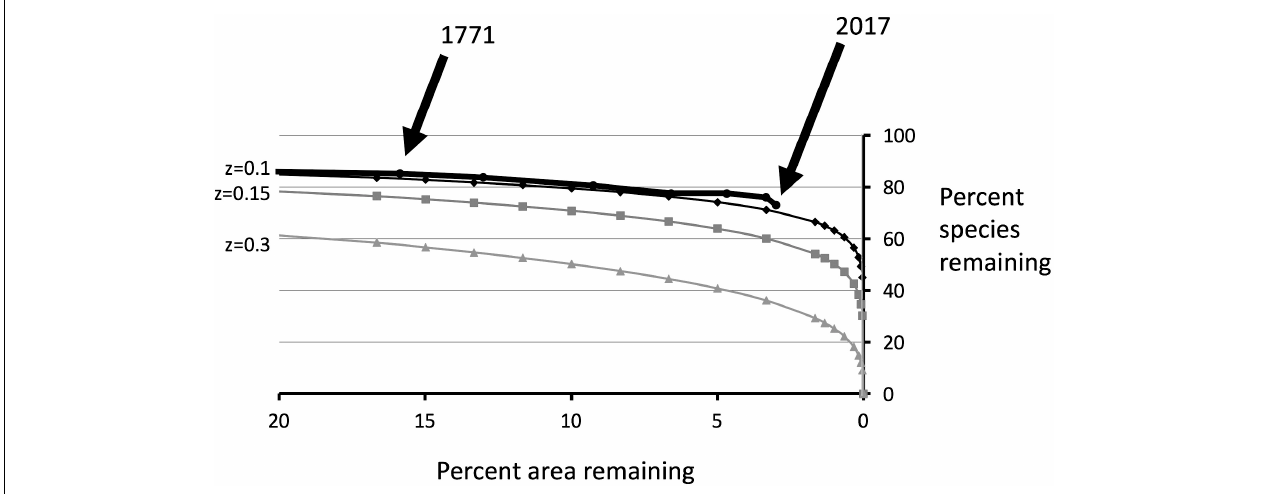
FIGURE 4 | Thick line: estimated species–area curve for extinction due to habitat destruction (actual). Other lines give theoretical curves based on the species–area curve S = cA z , with different values for z. The historical species–area curve matches fairly closely the theoretical curve based on z =